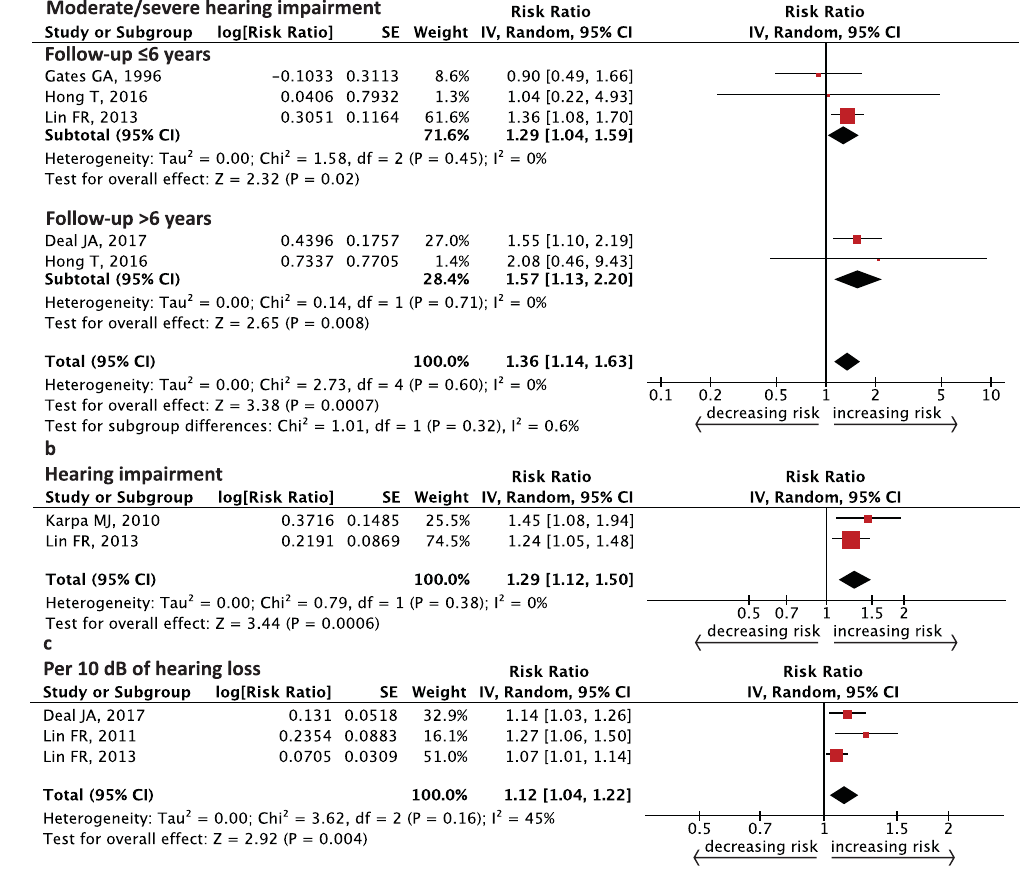
Figure 2. Forest plot showing the risk of incident cognitive impairment from peripheral auditory function. ( a ) Pooled relative risk from moderate/severe hearing impairment (PTA > 40 dB HL). ( b ) Pooled relative risk from hearing impairment (PTA > 25 dB HL). ( c ) Pooled relative risk per 10 dB of hearing loss. CI = confidence interval, dB HL = decibels hearing level, IV = inverse variance, PTA = pure-tone average, SE = standard error.